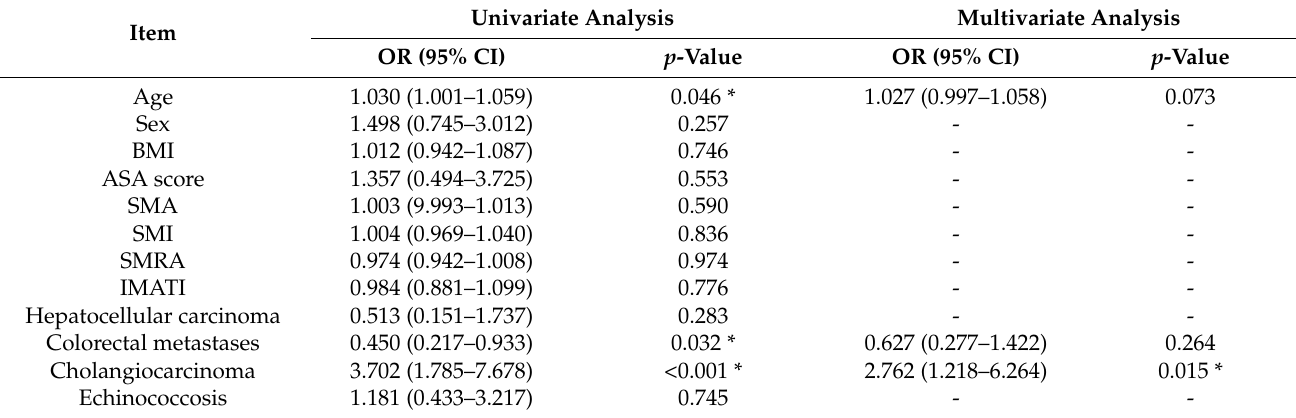
Table 3. Predictive factors of major complications.